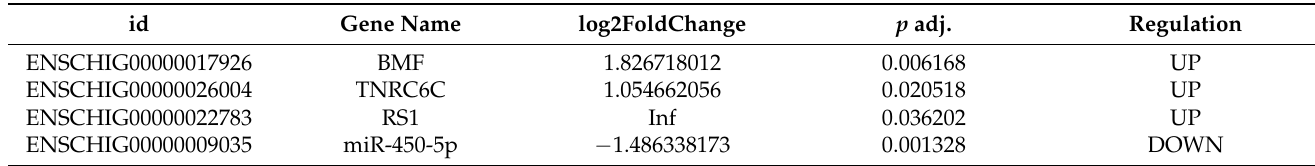
Table 3. Sequencing differential expression